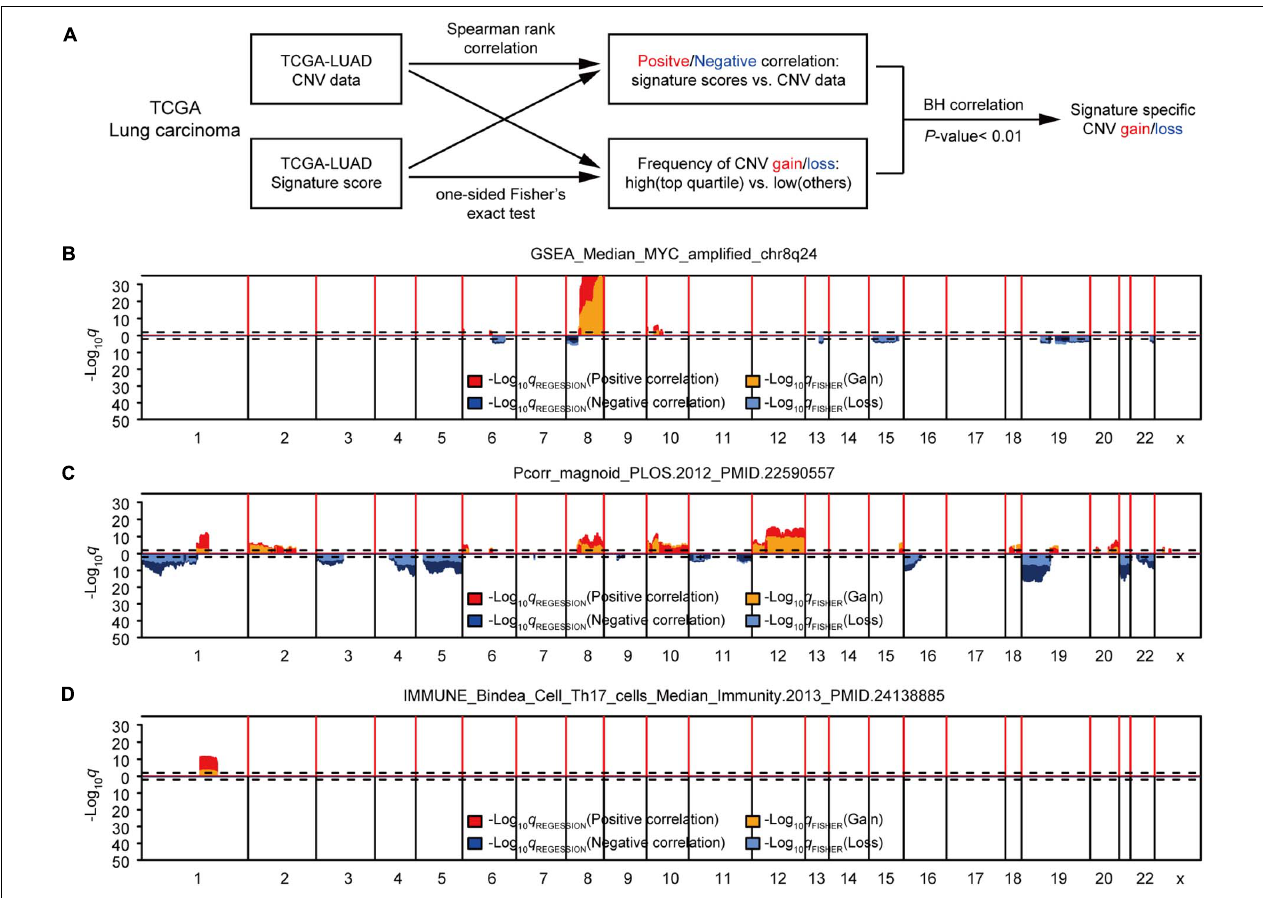
FIGURE 1 | Identification of gene expression signature-specific CNVs in lung adenocarcinoma. (A) Schematic overview of the strategy used to identify CNVs associated with gene signatures. Gain/loss indicates DNA copy number gains or losses; Positive/Negative indicates positive or negative association. (B,D) Spearman rank correlation was used to identify genes that were positively (red) or negatively (dark blue) correlated with gene signatures, and Fisher’s exact test was used to compare the frequency of copy number gains (orange) or losses (light blue) in GSEA_Median_MYC_amplified_chr8q24 (B) , Pcorr_magnoid_PLOS.2012 (C) , and IMMUNE_Bindea_Cell_Th17_cells_Median_Immunity.2013 (D) . Dashed lines indicate the significance threshold ( q = 0.01). Only the q values for genes that were significant in both analyses were plotted. In each figure, chromosome boundaries are indicated by vertical black lines.